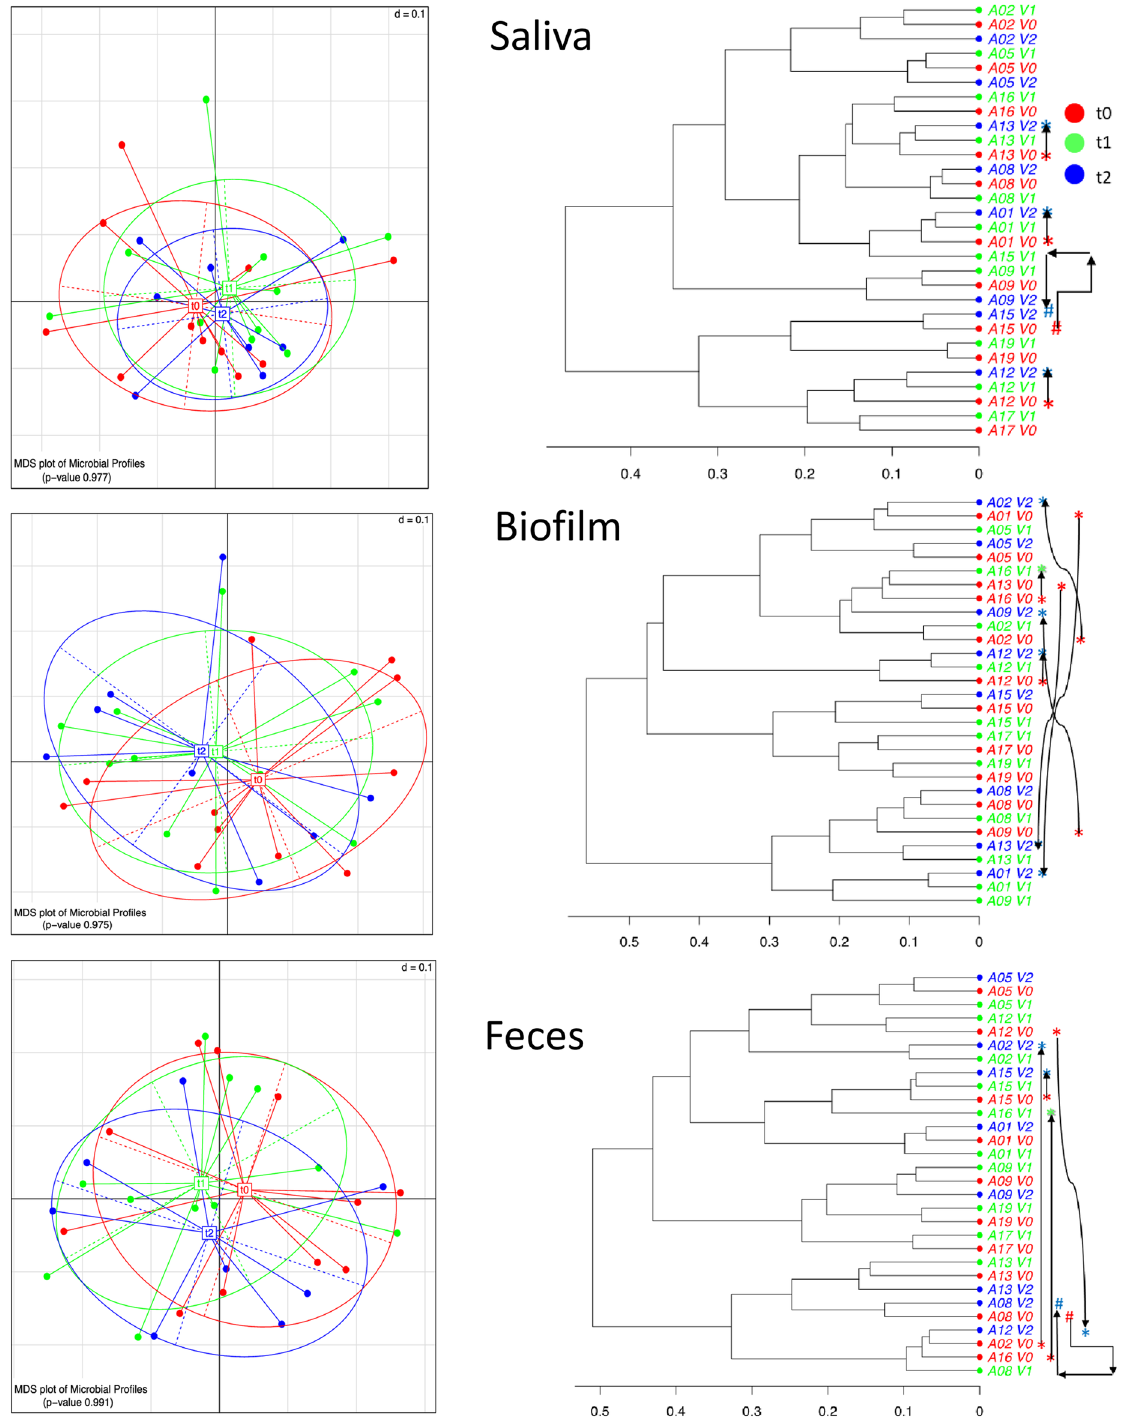
Figure 2. Analysis of β-diversity. Left: multidimensional scaling (MDS): over all taxa, the beta-diversity was not significantly different between the saliva, biofilm, and fecal samples collected at three different time points, t0 (before switch to SFOH), t1 (one week after SFOH switch), and t2 (four weeks after SFOH switch). Right: Cluster analysis and intra-patient dynamical change of microbiome. Changes that appear significant are followed by arrows. Patients with such a shifting microbiome (named shifters) were A01 (saliva, biofilm), A02 (biofilm, feces), A09 (biofilm), A12 (saliva, biofilm, feces), A13 (saliva, biofilm), and A16 (biofilm, feces, with data for t0/1 only). Microbiomes of patients A05, A08, A15, A17, A19 (non-shifters) appeared quite stable, independent of specimen. In a subgroup here, however, two specimens (saliva of A15 and feces of A08) changed from t0 to t1, but t2-microbiome clustered again with t0, following a boomerang